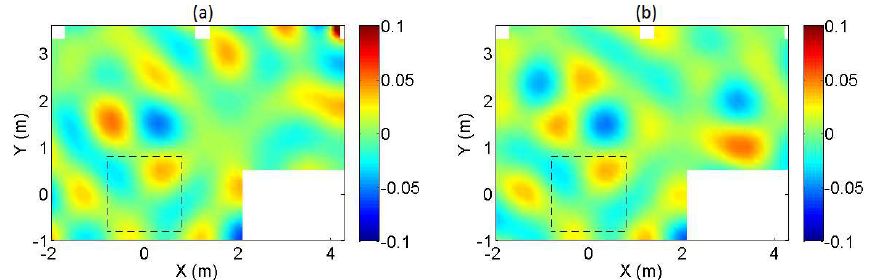
Figure 9. Target ( a ) and reconstructed ( b ) field of the reference room, regularized β = 0.33.